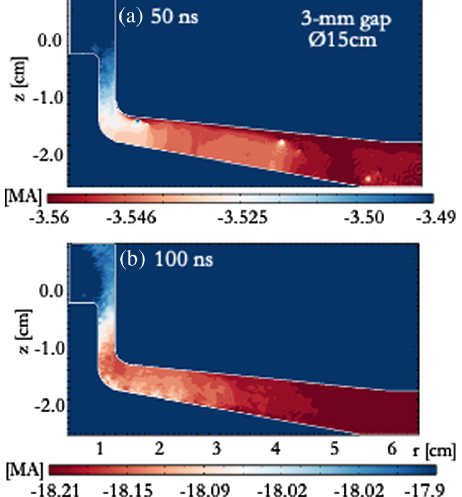
FIG. 12. Current distribution in the ∅ 15 cm 3-mm gap sim- ulation [Fig. 8(c)] at (a) 50 ns and (b) 100 ns.